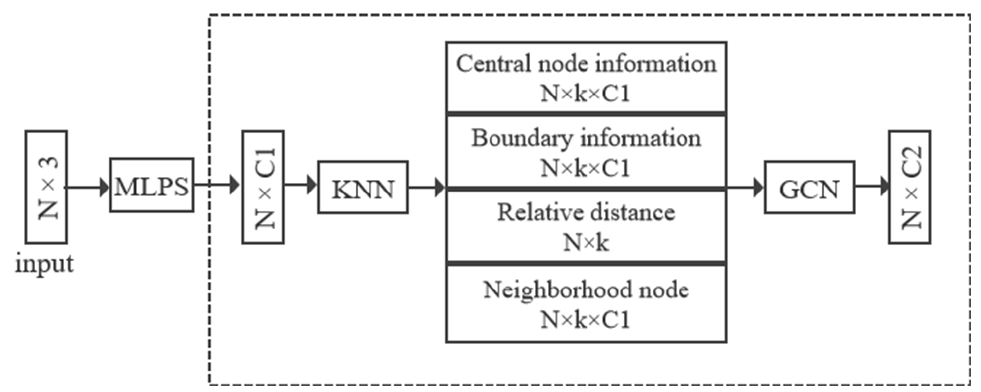
Figure 4. Feature extraction module using enhanced